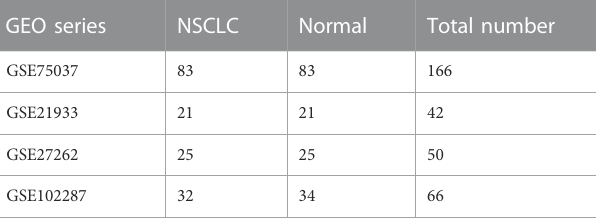
TABLE 1 The composition of four different gene expression omnibus